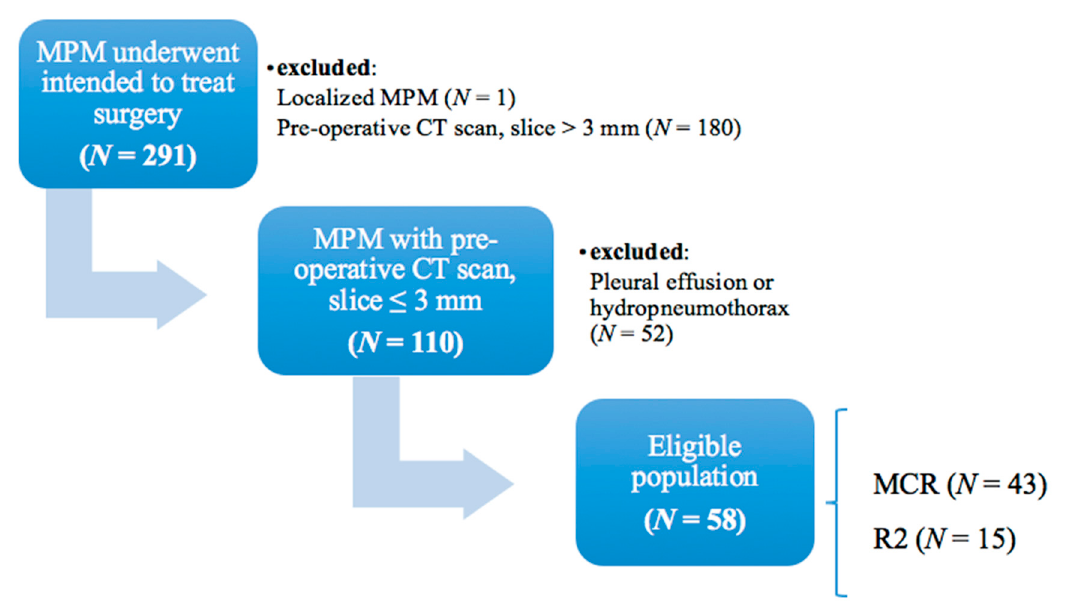
Figure 1. Flow diagram detailing study cohort. Final eligible population was composed by 43 patients underwent macroscopic complete resection (MCR), and 15 patients with an unresectable disease underwent explorative thoracotomy with a R2 resection (R2). MPM: malignant pleural mesothelioma; CT: computed tomography.